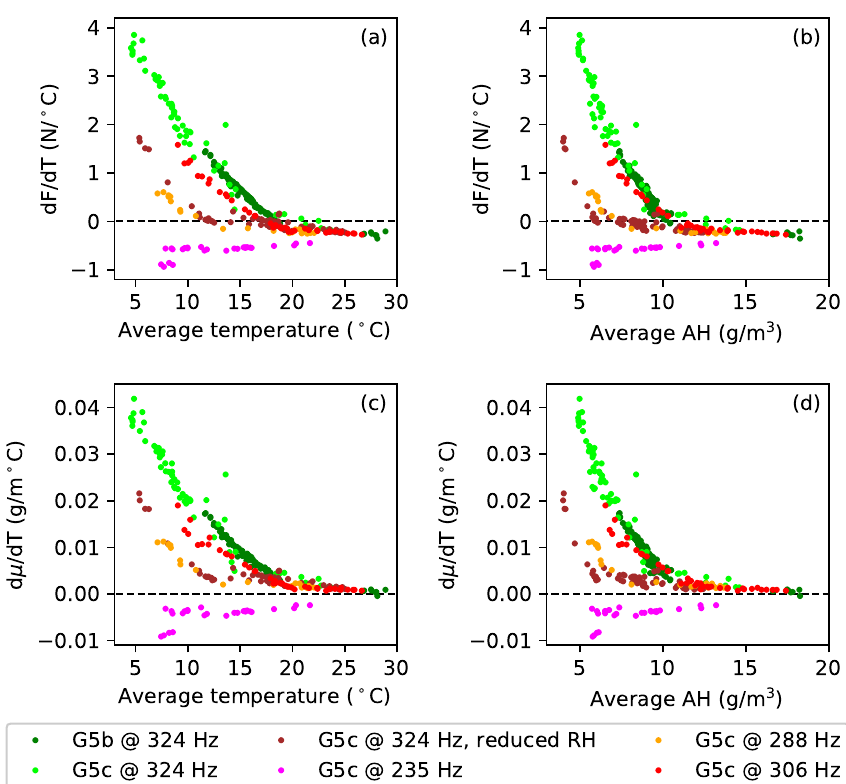
Figure 14. ( a , b ) The tension thermal sensitivity dF / dT values, and ( c , d ) the linear density thermal sensitivity d µ / dT values, for each temperature cycle during the extended tests, plotted against the average temperature and absolute humidity during the same